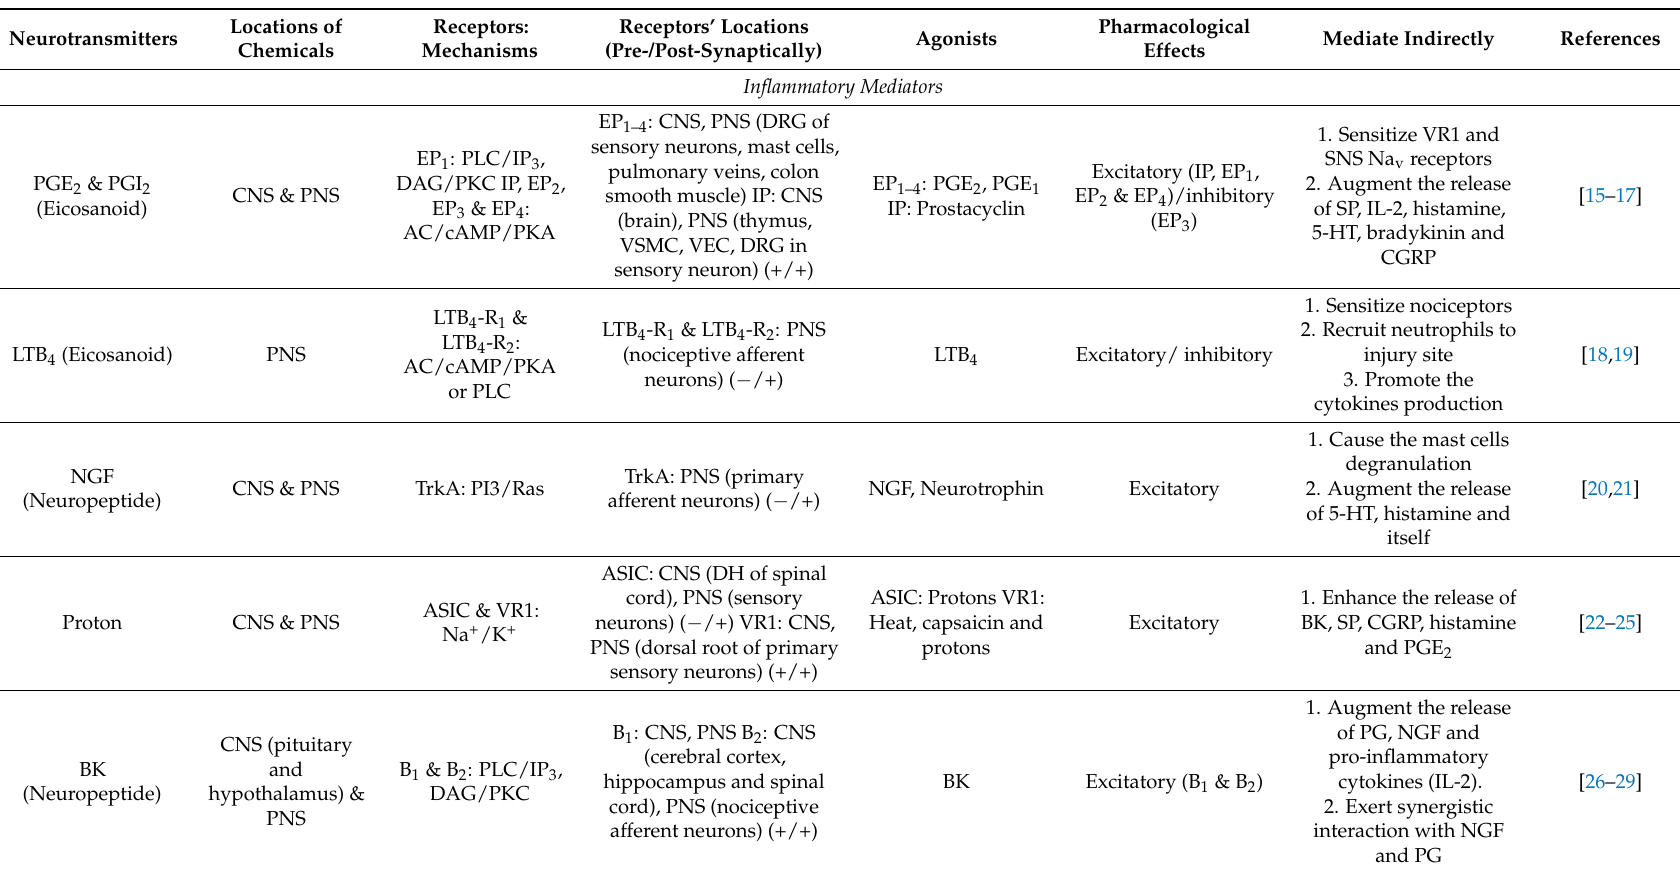
Table 1. The pain-associated neurotransmitters releasing location, their cognate receptors’ locations, signaling mechanism pathways involved, agonists and pharmacological effects involved in the pain